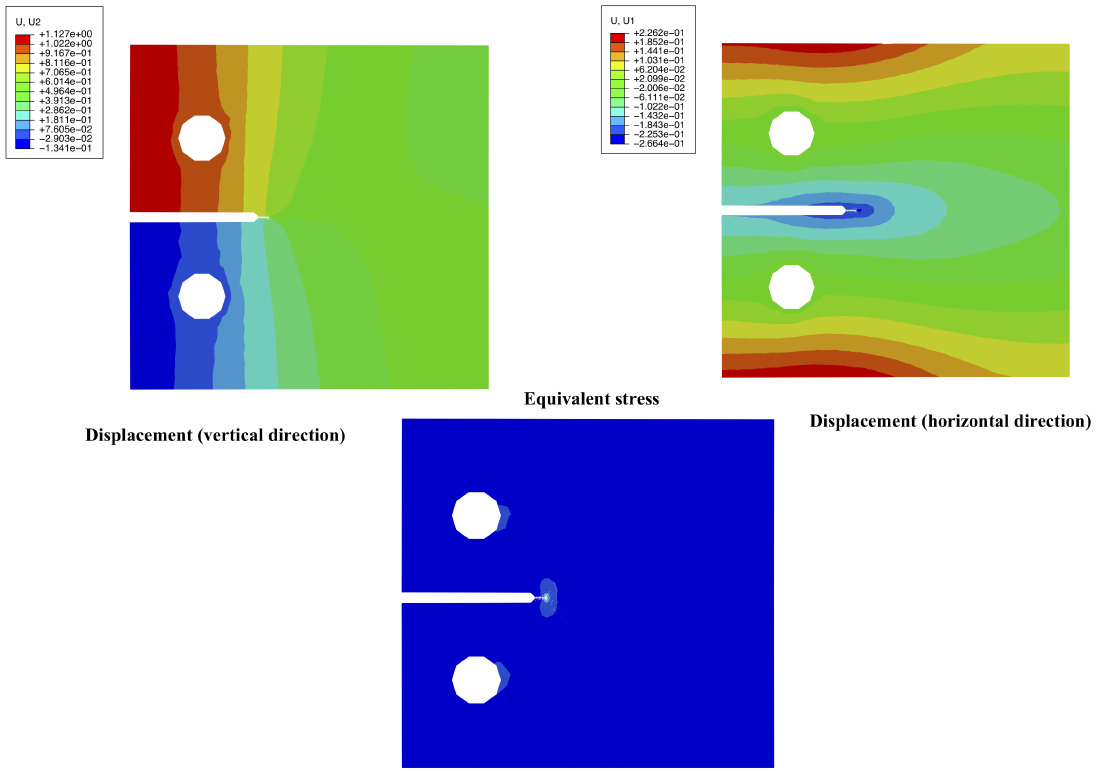
Figure 4. Model creation to compute the values of K of the entire system and σ yy , at corresponding values of θ .